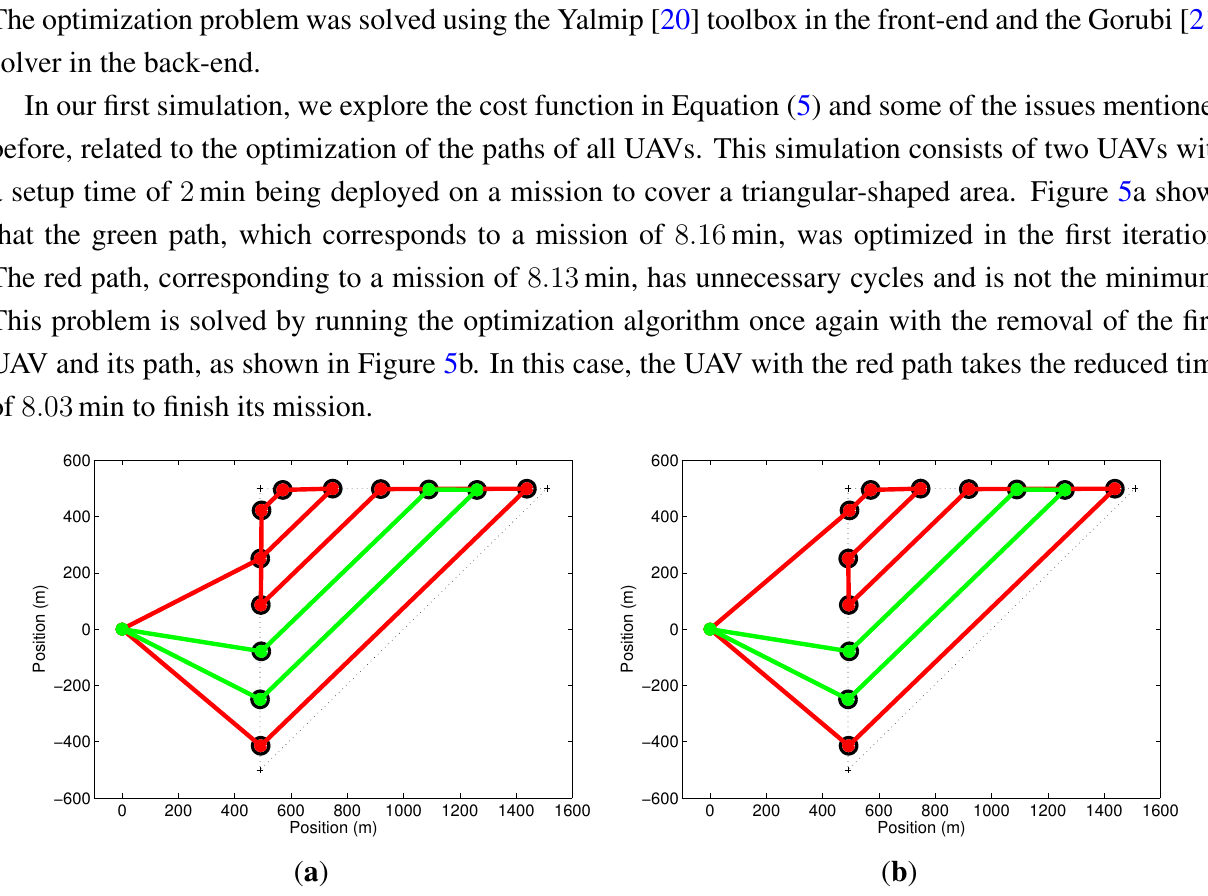
Figure 5. Effect of the cost function. ( a ) The mission represented by the green path is optimized, but the other (red) is not the minimum; ( b ) By removing the largest path and running the optimizer again, all paths are